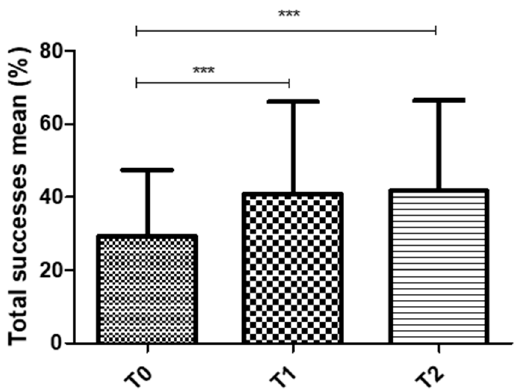
Figure 4. Representation of the composite success (mean of both ears) for overall participants obtained at T0, T1 and T2. *** p < 0.001.